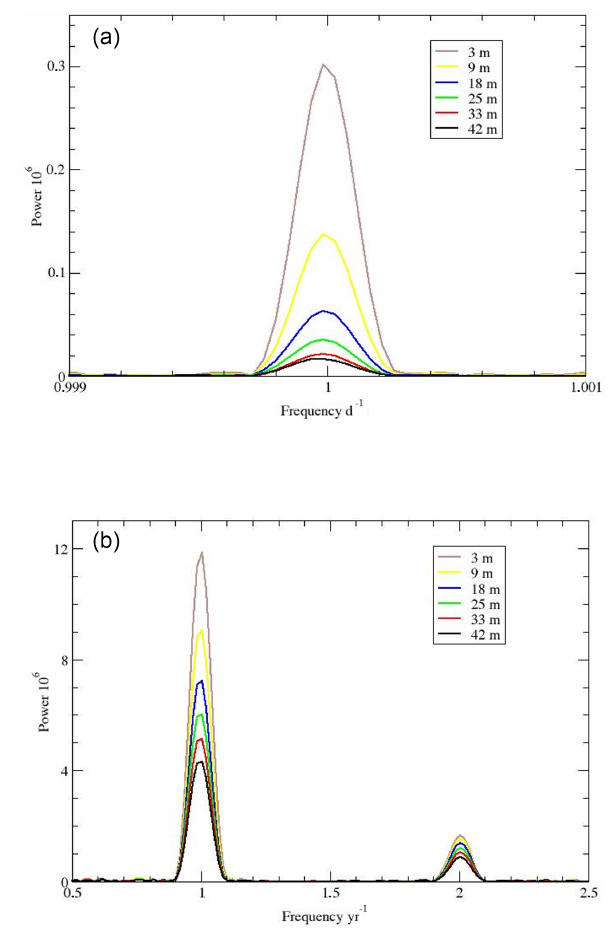
Figure 6. Harmonic analysis of the temperature time series near diurnal (a) and annual/semi-annual (b) frequencies.